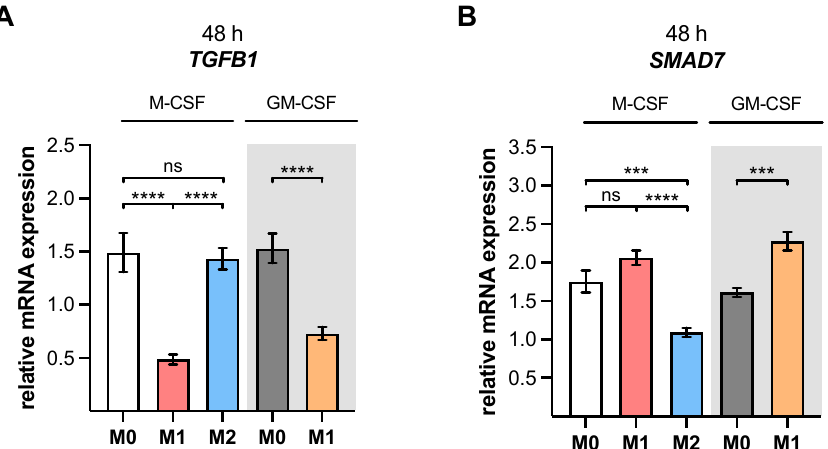
Figure 2. Gene expressions of polarized human monocyte-derived macrophages. Negatively selected monocytes (n, sample = 3; n, biological = 2; n, technical = 3) were differentiated to macrophages using M-CSF or GM-CSF (highlighted in grey). After 6 days, M Φ were stimulated with IFN- γ /LPS (M1), IL-4 (M2), or with no additive (M0). Cells were harvested after a polarization time of 48 h. The relative gene expressions of ( A ) TGFB1 and ( B ) SMAD7 were determined using qRT-PCR. The data were analyzed using a one-way ANOVA, followed by Tukey’s multiple comparison tests, and expressed as mean ± SEM. ns (not significant), p < 0.001 (***), p < 0.0001 (****).